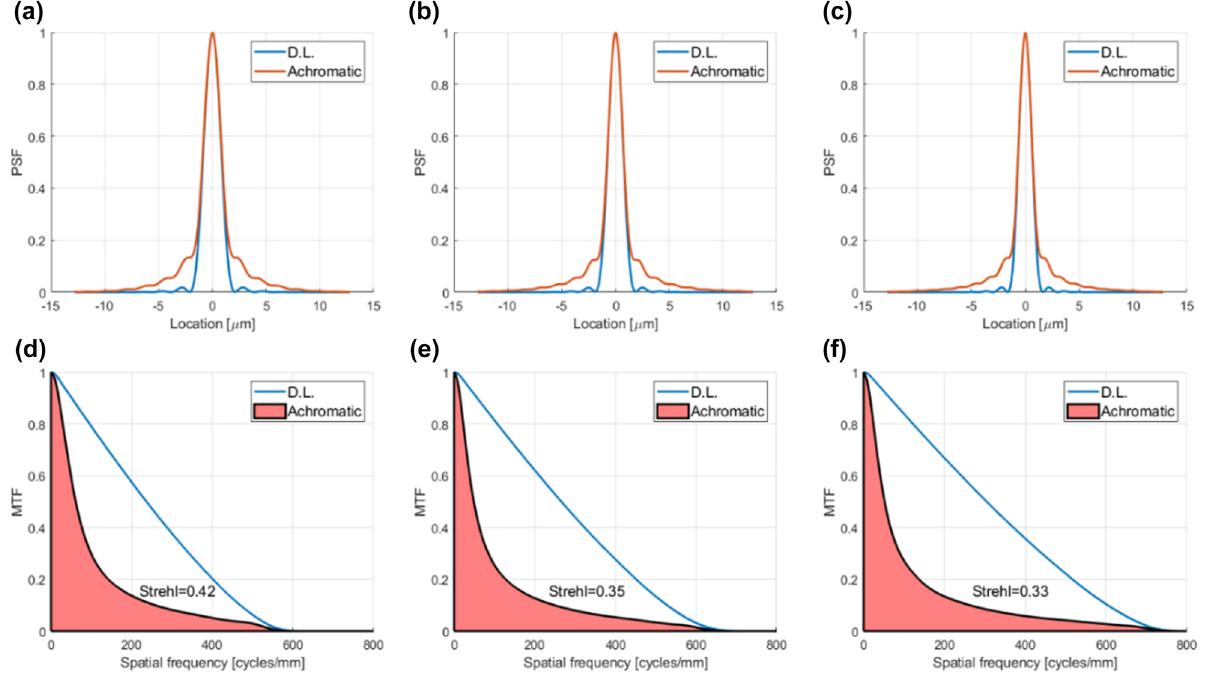
Figure 5: PSFs and MTFs of spatial multiplexed achromatic metalens over RGB spectral ranges, defined according to spectral response of nanoantennas given in [47], with lower and upper cutoffs at 450 nm and 650 nm, respectively. (a) R PSF cross section (b) G PSF cross section